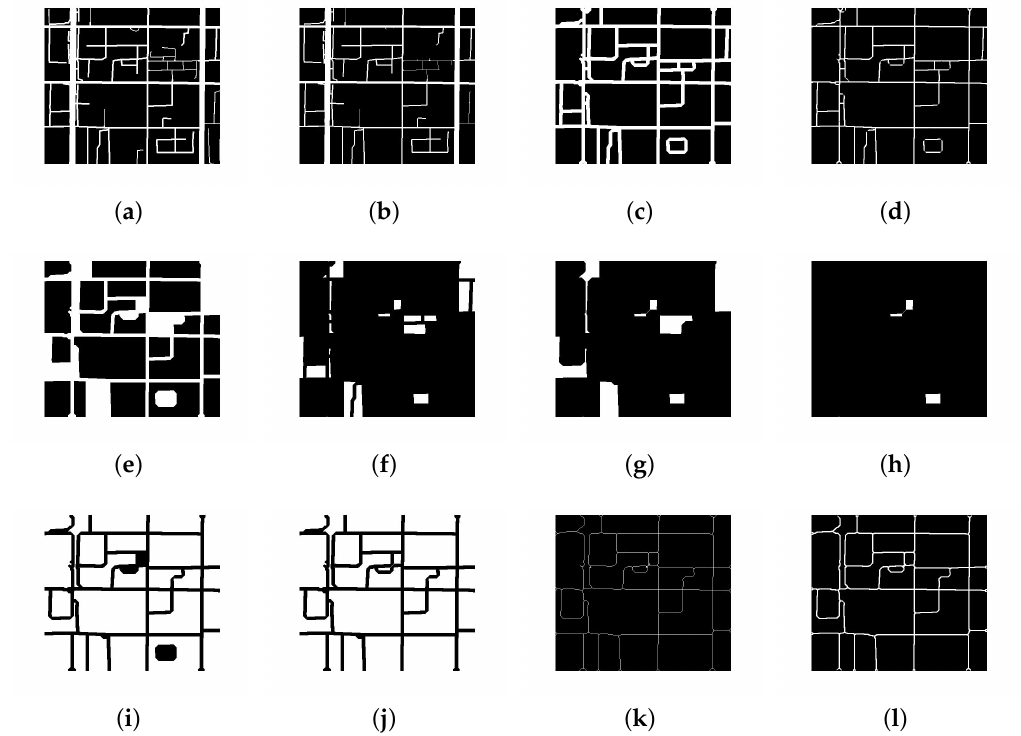
Figure 6. Details of city segmentation by road map. ( a ) Binary image of road network of a local region; ( b ) Apply erode operator and open operator to remove alleyways; ( c ) Apply dilate operator to smooth the residual of alleyways; ( d ) Apply thin operator to obtain the skeleton of the road network; ( e ) Calculate region area and remove the small regions; ( f ) The small regions removed by last step; ( g ) Apply dilate operator to the small regions to link the near regions; ( h ) The small regions removed finally; ( i ) Add the expansive smaller regions back; ( j ) Apply thin operator to obtain the skeleton of the road network again; ( k ) Apply dilate operator to smooth the road residual; ( l ) Add the expansive small regions